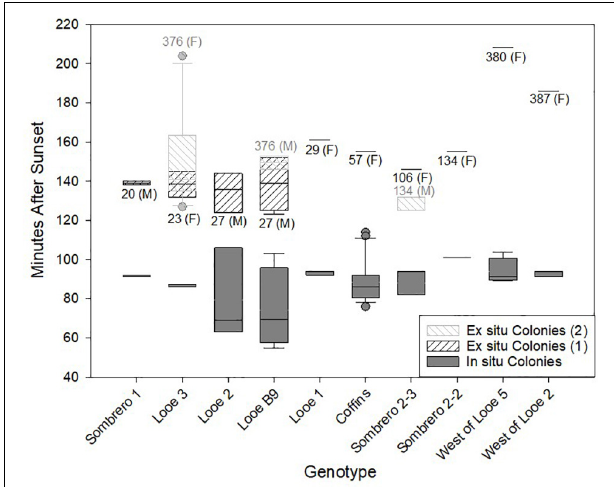
FIGURE 6 | Spawning times (minutes after sunset) of Dendrogyra cylindrus genotypes observed both in situ (solid gray) and ex situ (hashed). The number of days held ex situ and the gender (M/F) are indicated beneath the ex situ box plots. For three genotypes, multiple ex situ spawning events were observed and separated by shading. Genotype Sombrero 2-3 spawned during two consecutive months and switched genders. Genotypes Looe 3 and Looe 2 spawned in both 2017 and 2018. For all three of these, the second spawning event (2) is indicated by the lighter crosshatch.